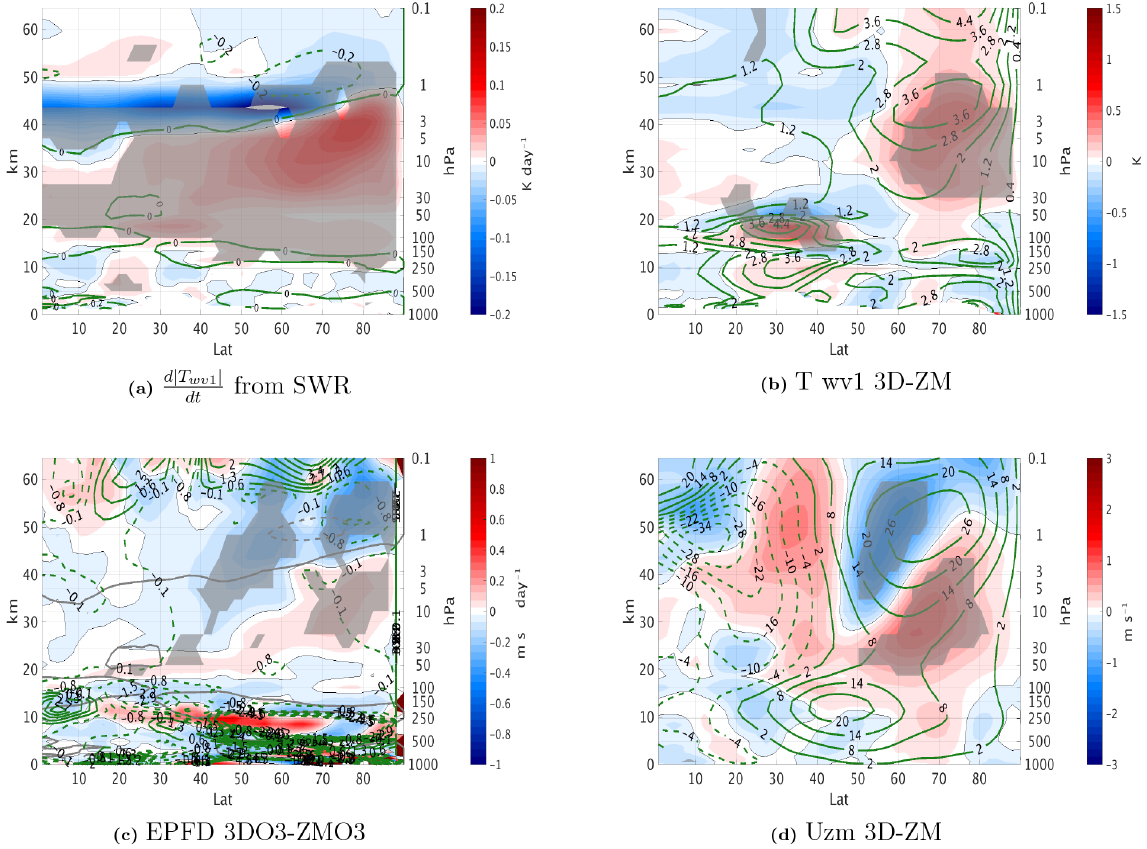
Figure 3. September mean differences between the 3DO 3 and ZMO 3 run for all years for temperature wave 1 amplitude tendency from shortwave radiation (SWR) (a) , temperature zonal wave 1 amplitude (b) , EP flux divergence (c) , and zonal wind (d) . In panel (c) , the gray line in the upper stratosphere indicates the height where ozone and temperature zonal wave 1 correlation changes from positive to negative. Statistically significant areas are shown by gray